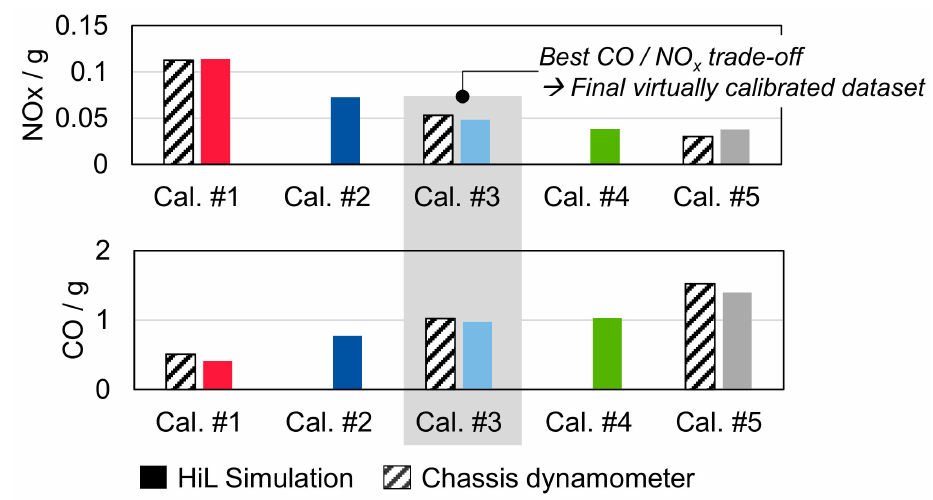
Figure 17. Impact of different calibration strategies and validation of simulation